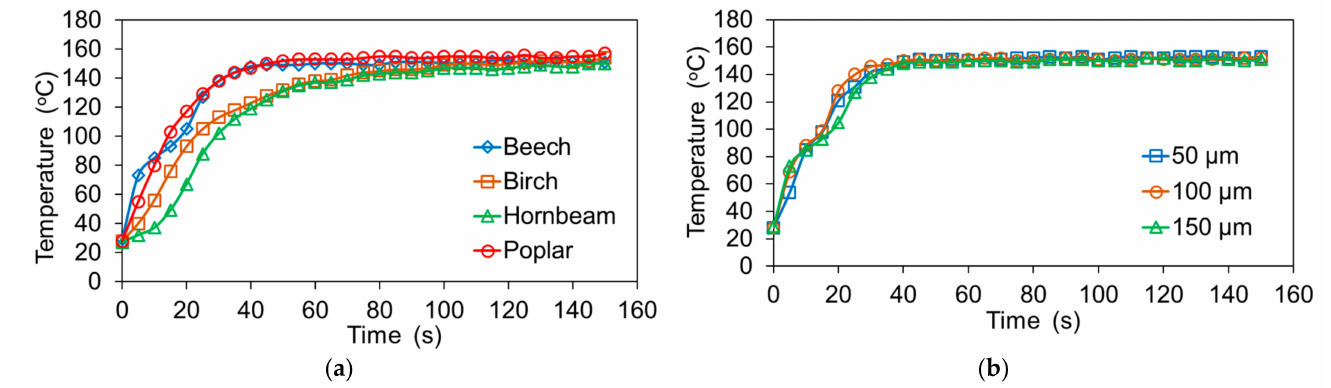
Figure 5. Core temperature curves of plywood samples made with ( a ) veneers of different wood species and rLDPE film of 150 µ m thickness, and ( b ) beech veneers and different thicknesses of rLDPE